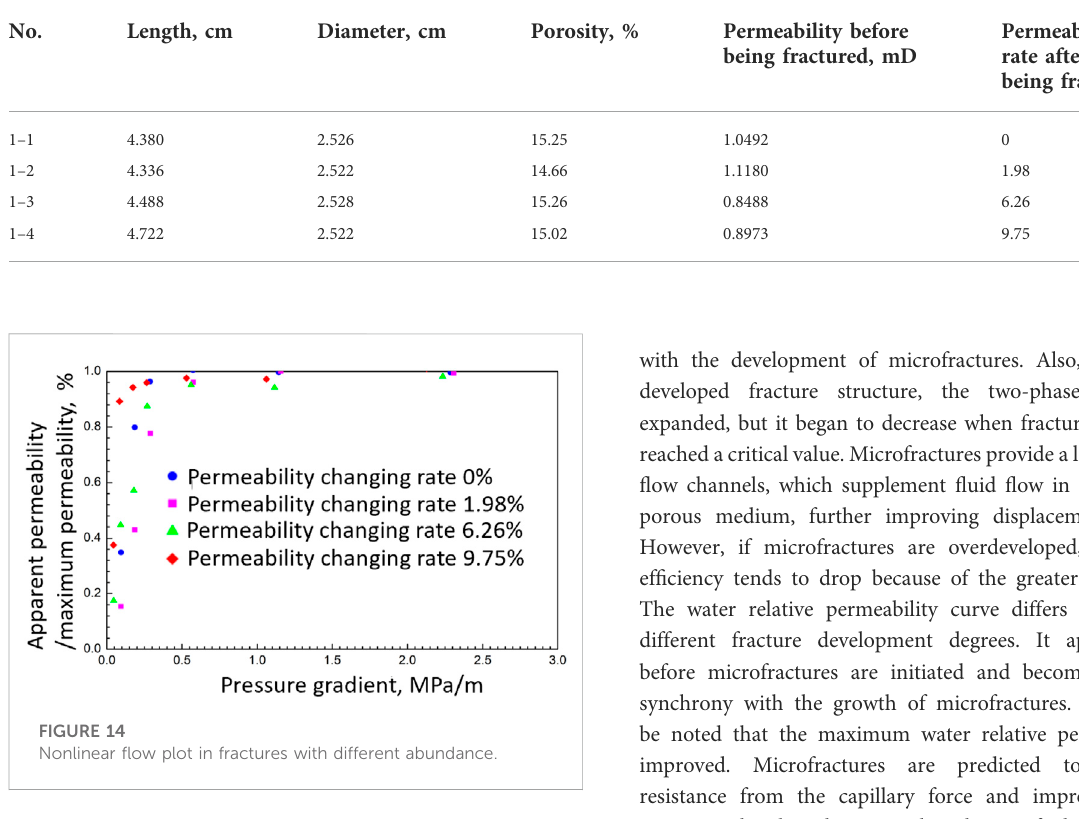
TABLE 3 Fracture generation curves in slit cores.